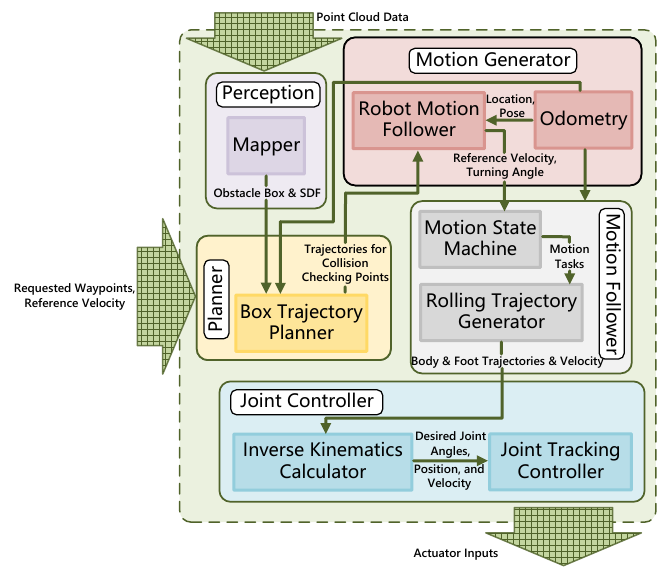
Figure 3. The schematic diagram of planning framework working on BIT-NAZA